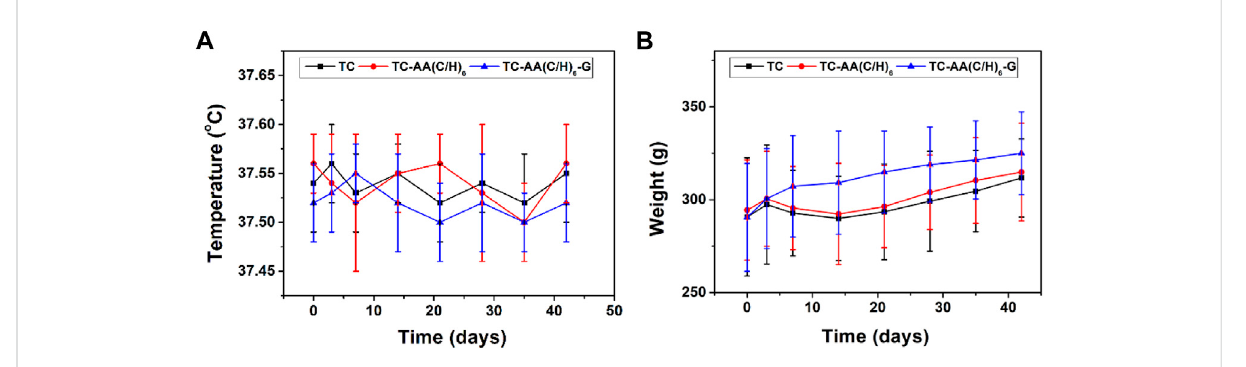
FIGURE 6 Postoperative changes in temperature (A) and weight (B) of animals.